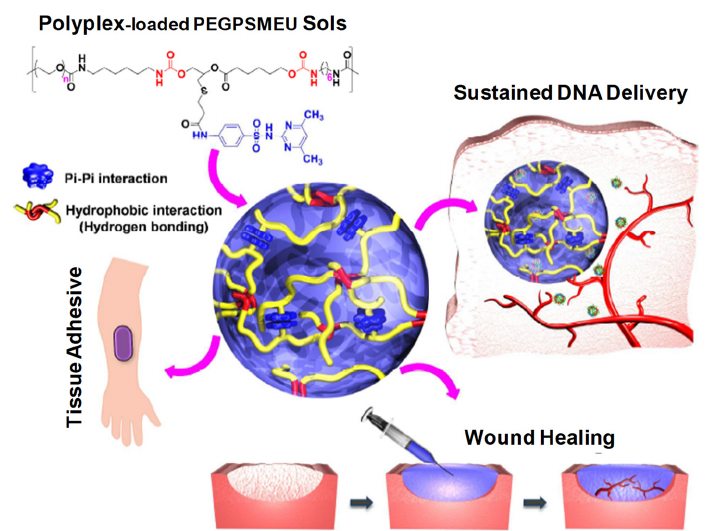
Figure 23. Schematic concept of sol-to-gel phase transition of polyplex-loaded PEGPSMEU copoly- mers sols, subcutaneous administration, controlled released via diffusion, effective absorption onto skin and wound healing. Reprinted with permission from ref. [7]. Copyright © 2020 from Journal of Controlled Release , Elsevier.